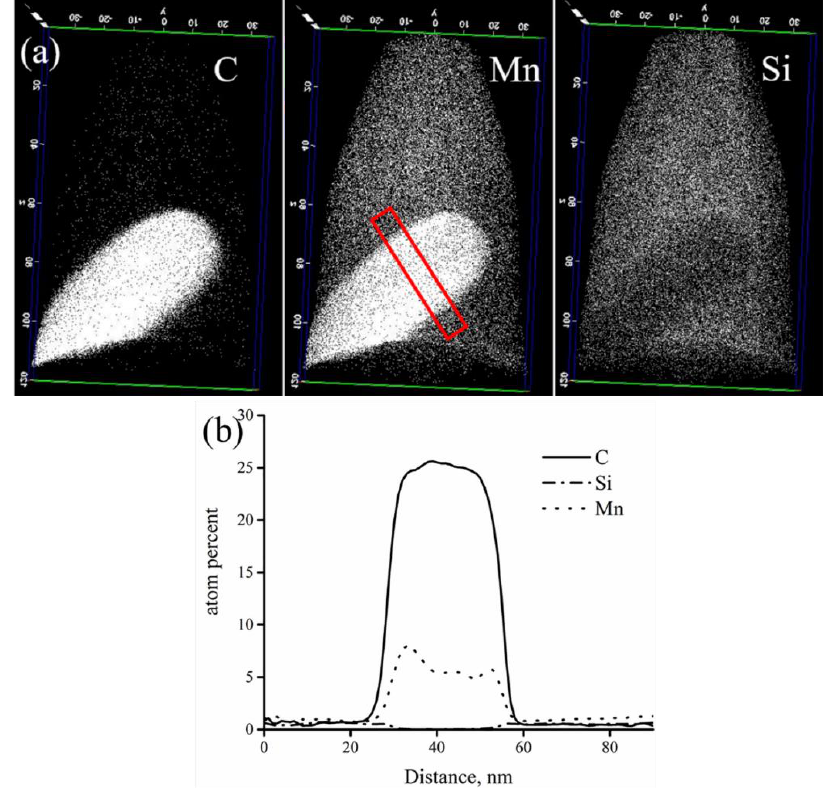
Figure 11. The 3D element maps of the APT needle taken from pearlite ~3 μm beneath the WEL ( a ) and the composition profile of regions enclosed in the rectangle in ( a ) is shown in ( b ).